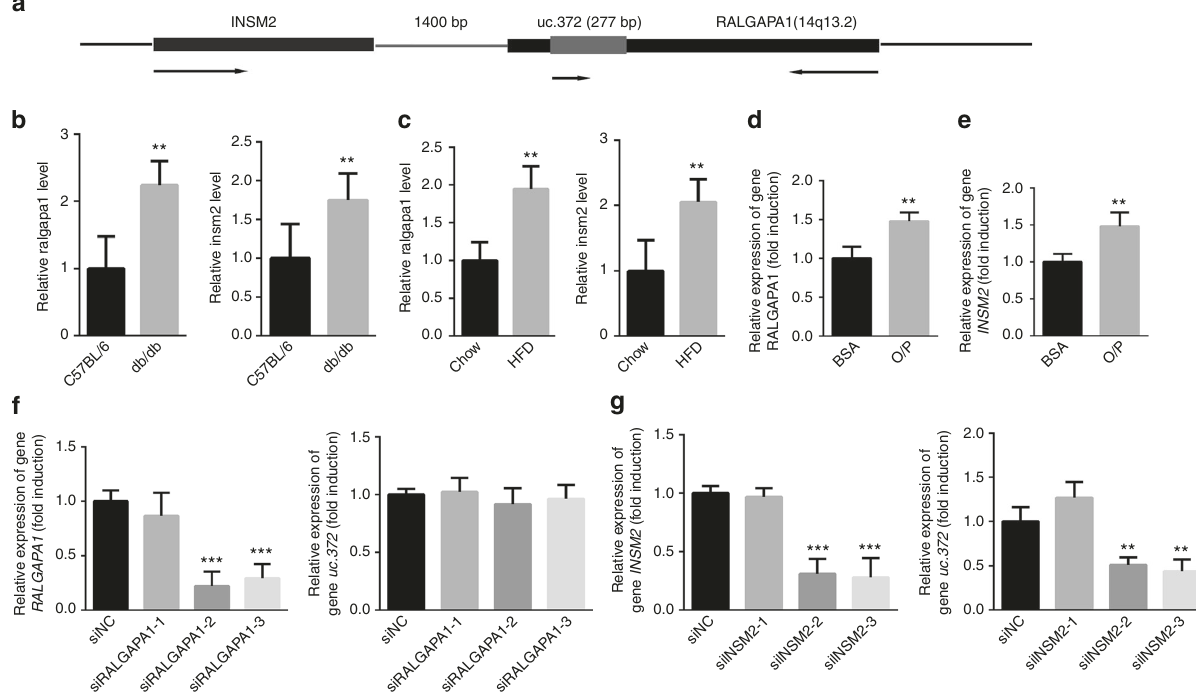
Fig. 6 uc.372 expression is dependent on transcription of INSM2. a Schematic analysis of uc.372 location. b Ralgapa1 and insm2 expression in the liver of 8- week-old male db/db mice ( n = 5). c Ralgapa1 and insm2 expression in the liver of 10-week-HFD-fed mice ( n = 5). d The mRNA level of RALGAPA1 in the HepG2 cells treated with 300 μ M O/P mixture for 48 h ( n = 3). e The mRNA level of INSM2 in the HepG2 cells treated with 300 μ M O/P mixture for 48 h ( n = 3). f The levels of RALGAPA1 and uc.372 after silencing RALGAPA1 in HepG2 cells for 48 h ( n = 3). g The levels of INSM2 and uc.372 after silencing INSM2 in HepG2 cells for 48 h ( n = 3). Data are mean ± SEM; ** P < 0.01; *** P < 0.001 vs. control group ( b , c , d , e Student ’ s t -test; f , g analysis of variance